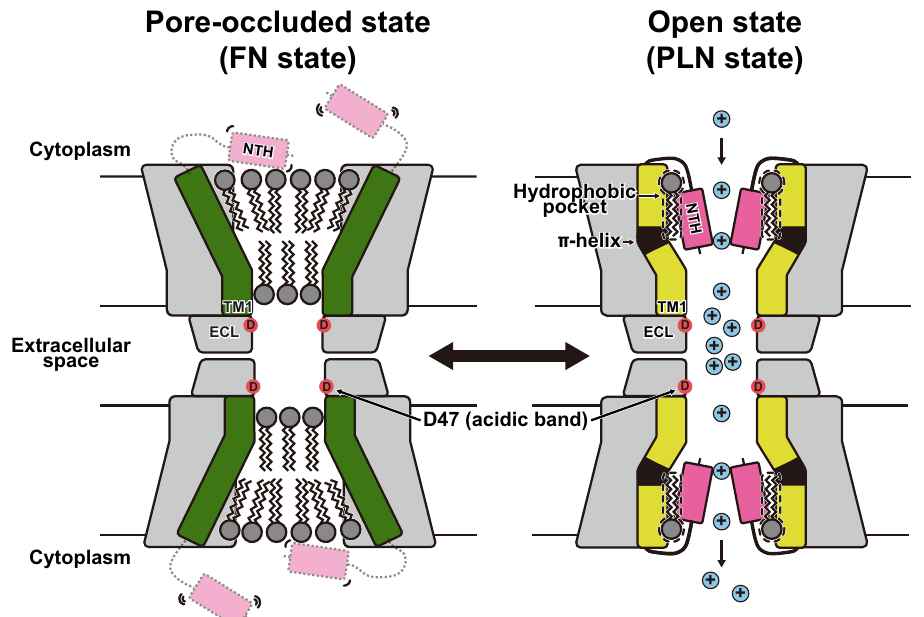
Fig. 5 | Overall model and unique structural features of Cx36. Schematic representation of Cx36 in the FN and PLN states. TM1 in the FN and PLN states, π -helix spanning residues 30 – 33, and NTH, are colored green, yellow, black, and magenta, respectively. The phospholipids, cations, and surface-exposed Asp47 at theECL1oftheacidicband,arerepresentedbythetailedgray,blue,andredcircles, respectively.The fl exibleNTHoftheFNstateisoutlinedbyalight-graydashedline.